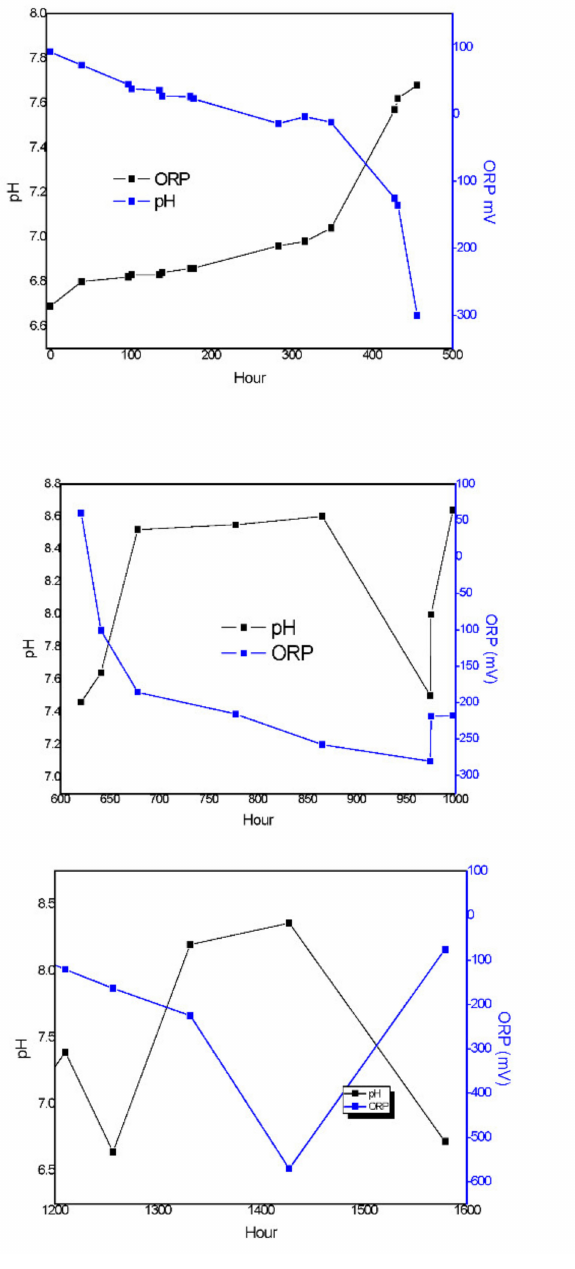
Figure 12. Profiles between pH and ORP